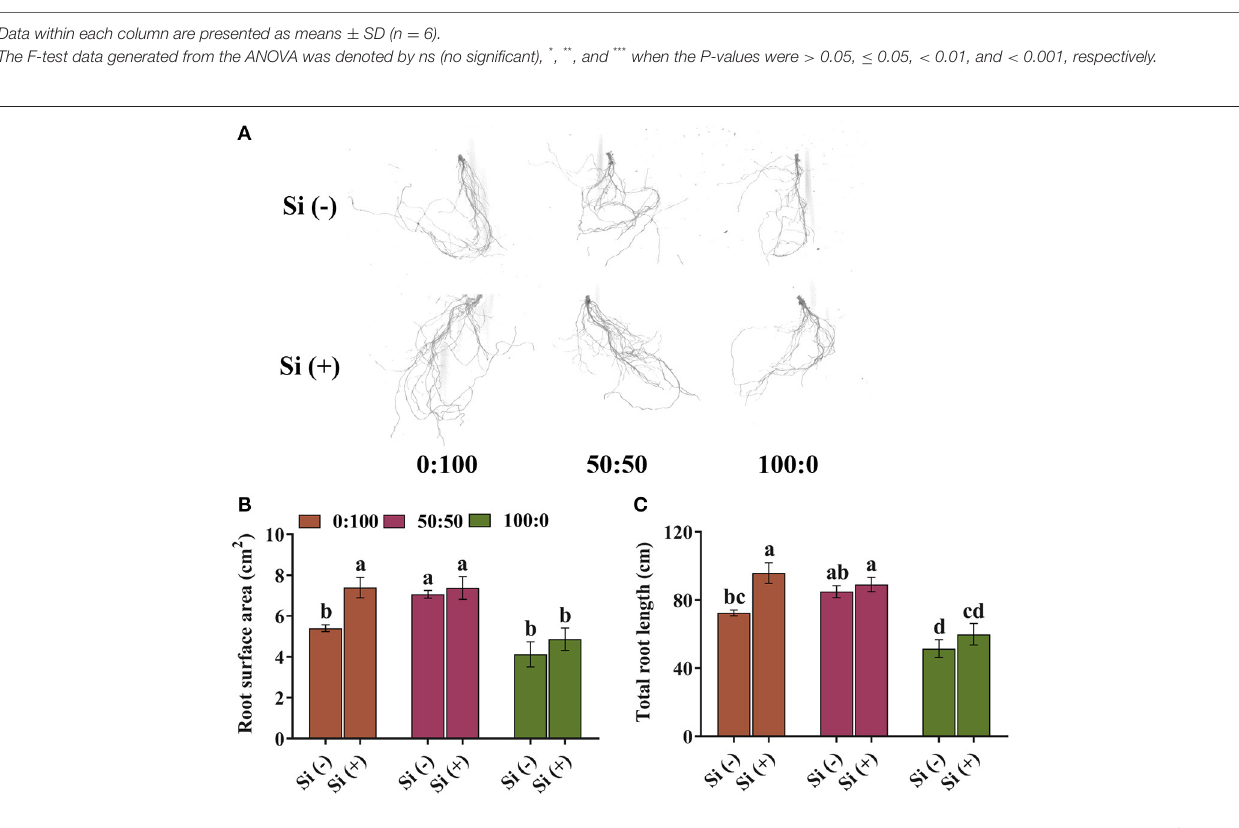
FIGURE 2 | (A) Scanned images of the root morphology and monitored parameters of (B) root surface area and (C) total root length in response to three NH + 4 :NO − 3 ratios with and without Si supplementations. Data in (B) and (C) are the mean ± SD of n = 6 biological samples; different letters over the columns represent significant differences at p < 0.05 following Duncan’s multiple range